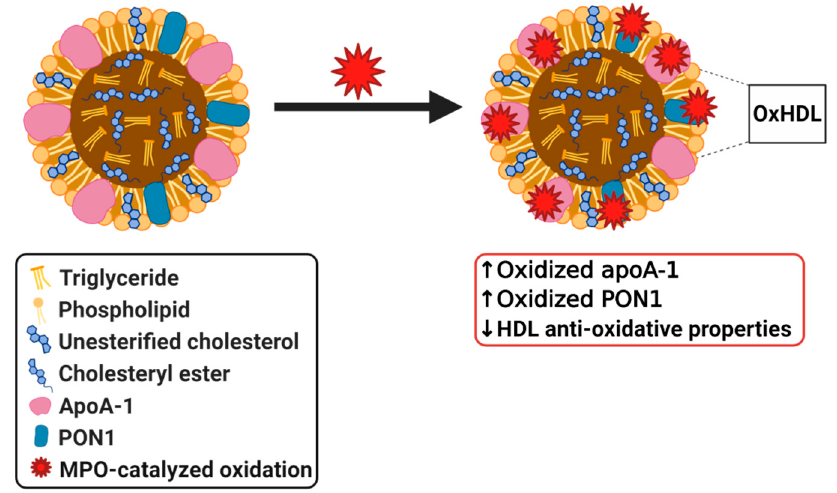
Figure 5. Simplified diagram of myeloperoxidase (MPO) modified dysfunctional HDL.